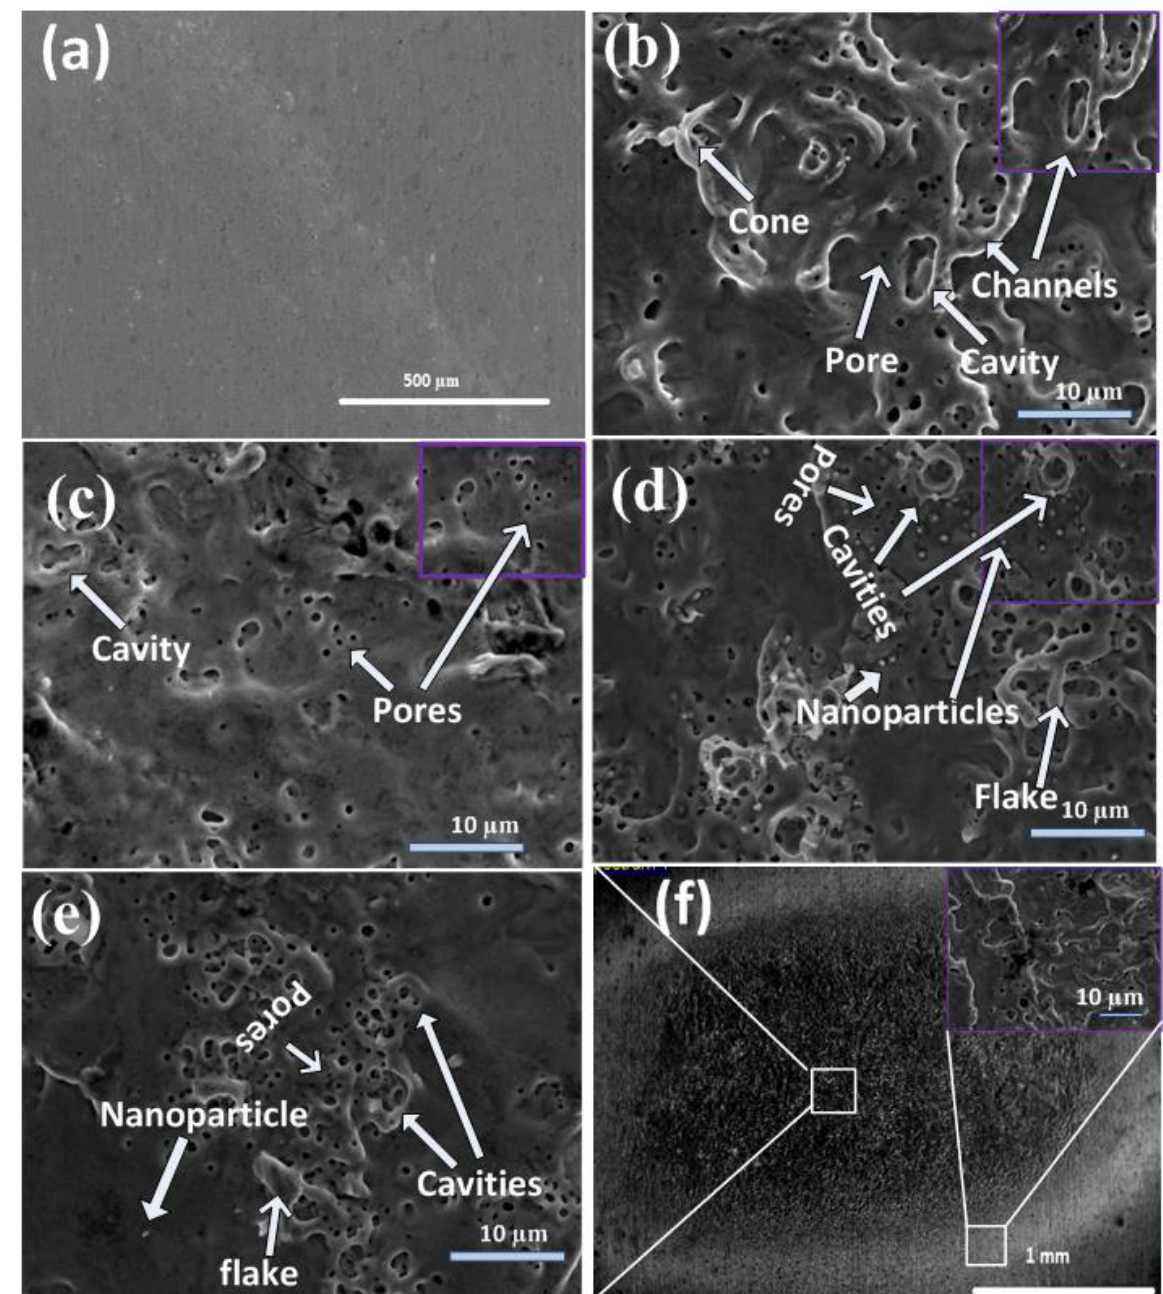
Figure 1. SEM micrographs showing comparison of differences in morphology of ( a ) unablated and central ablated areas of Cd targets surfaces exposed to ( b ) 500, ( c ) 1000, ( d ) 1500, and ( e ) 2000 laser pulses, and ( f ) show the full view of ablated region for 2000 laser pulses, at constant fluence value of 3.6 Jcm − 2 in deionized (DI) water.